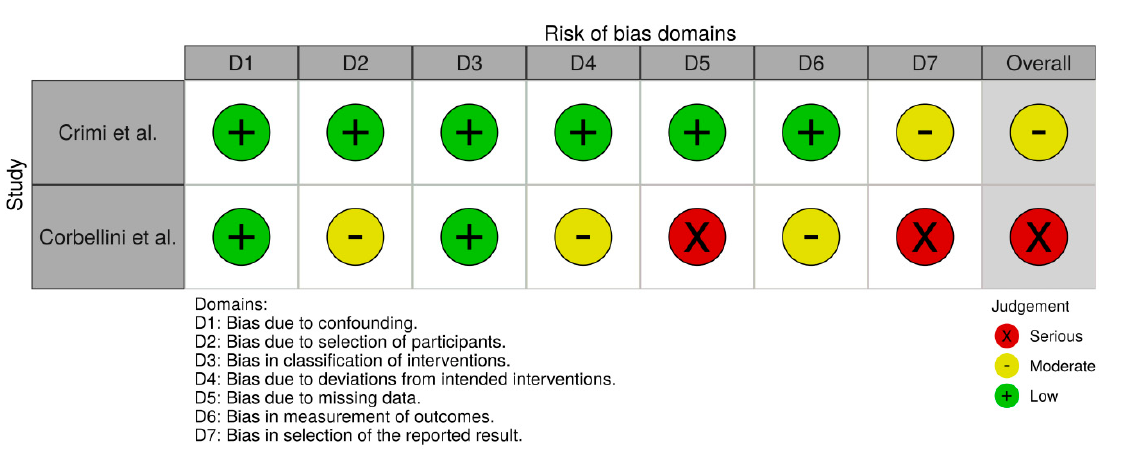
Figure 3. Risk of bias plot according to RoB2.